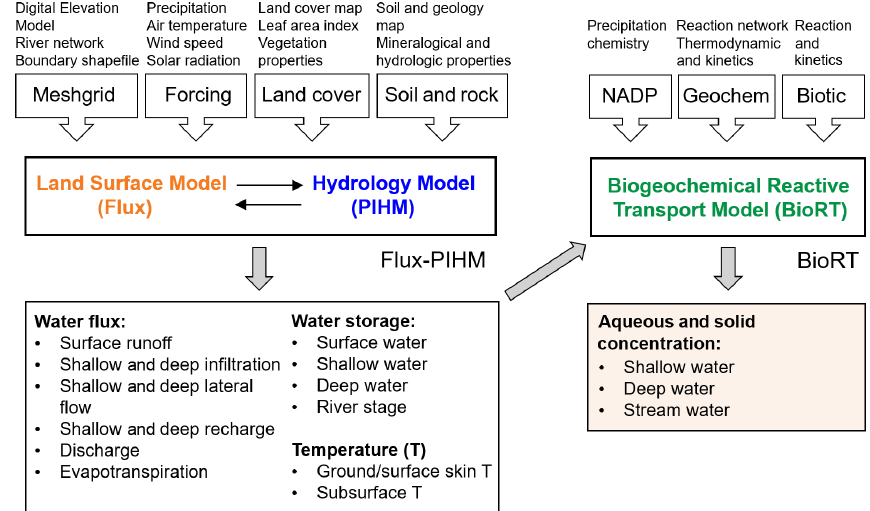
Figure 5. Model structure, input, and output of BioRT-Flux-PIHM. The Flux-PIHM takes in watershed characteristics including topography (digital elevation model, DEM), land cover, shallow- and deep-zone properties, and meteorological forcing time series and solves for water storage and ground and soil temperature. BioRT takes in water- and temperature-related output from Flux-PIHM and additional inputs such as precipitation chemistry and shallow- and deep-water chemistry and biogeochemical kinetics parameters and solves for aqueous and solid concentrations in the shallow and deep zone and stream water. NADP stands for the National Atmospheric Deposition Program. Table 1. Example applications of BioRT-Flux-PIHM. Watershed Size Model domain Modeled Reactions (rate laws: a : TST; Reference (km 2 )